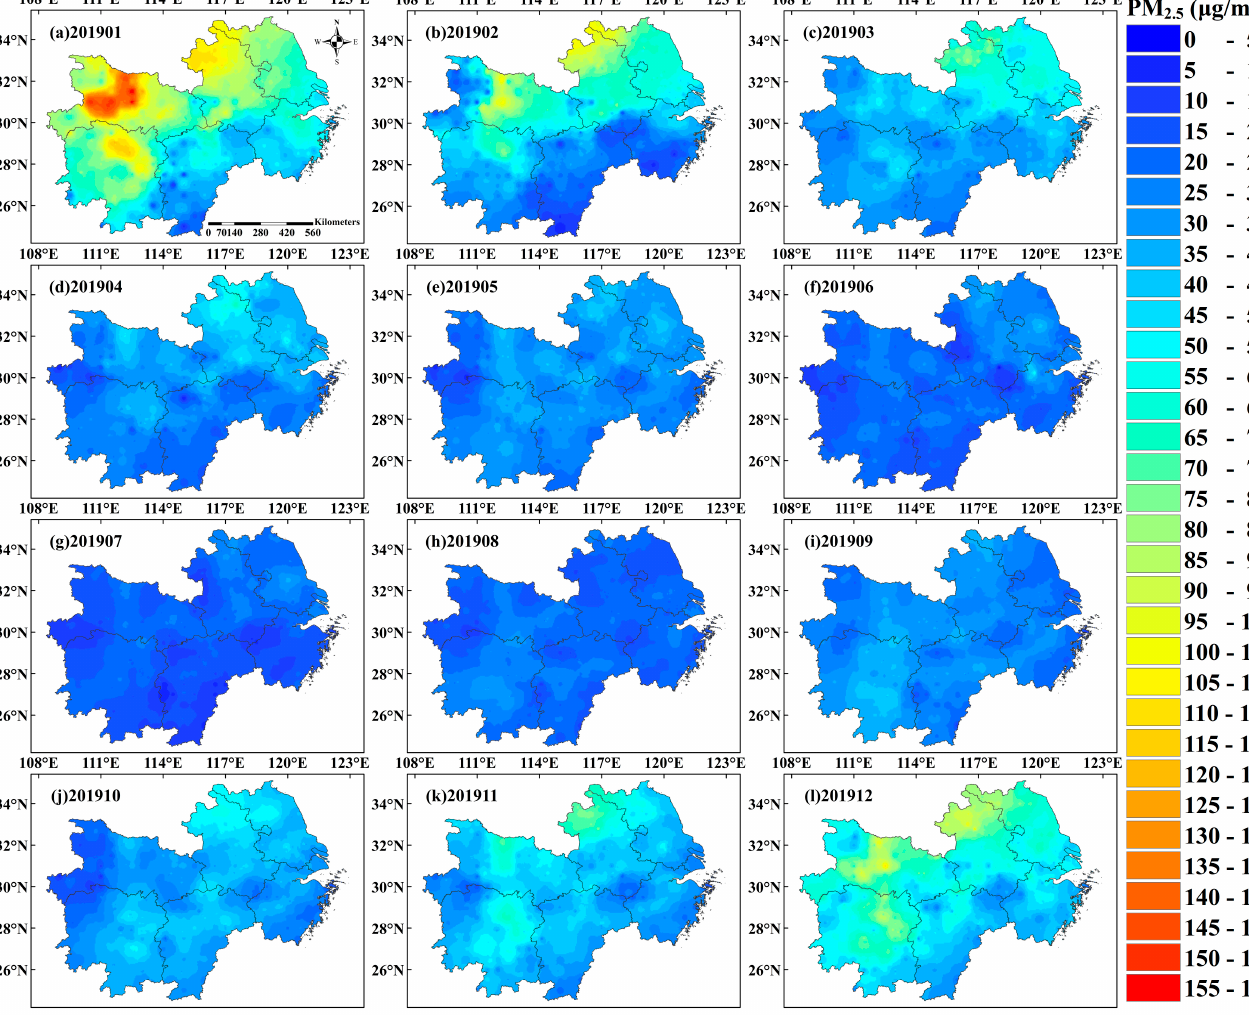
Figure 12. The spatial distribution of PM 2.5 concentrations from January to December 2019 ( a – l ) is shown by different color bands indicating the distribution of PM 2.5 concentrations.